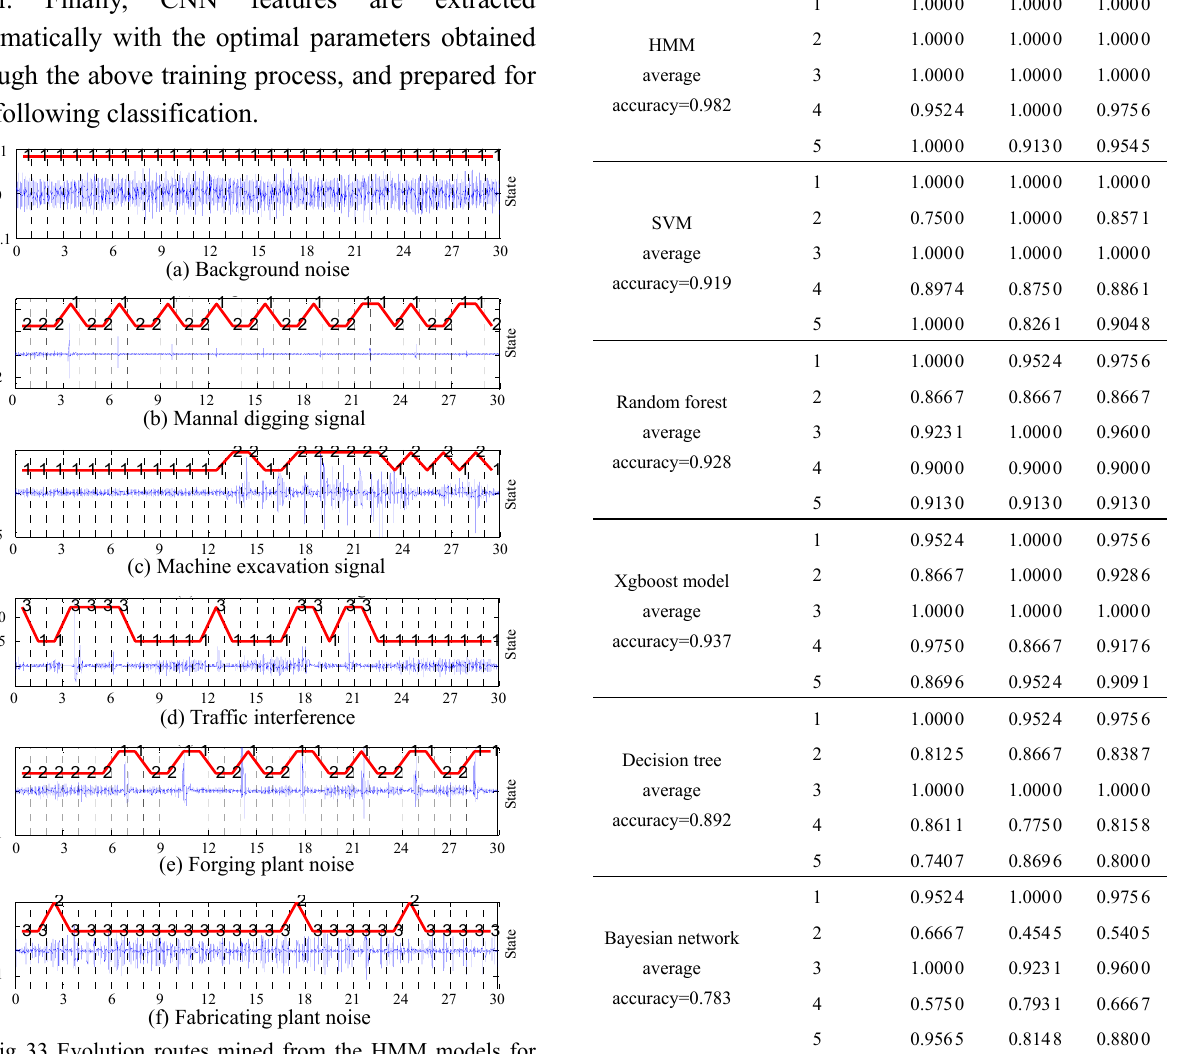
Fig. 33 Evolution routes mined from the HMM models for the six signal samples in Fig. 32.